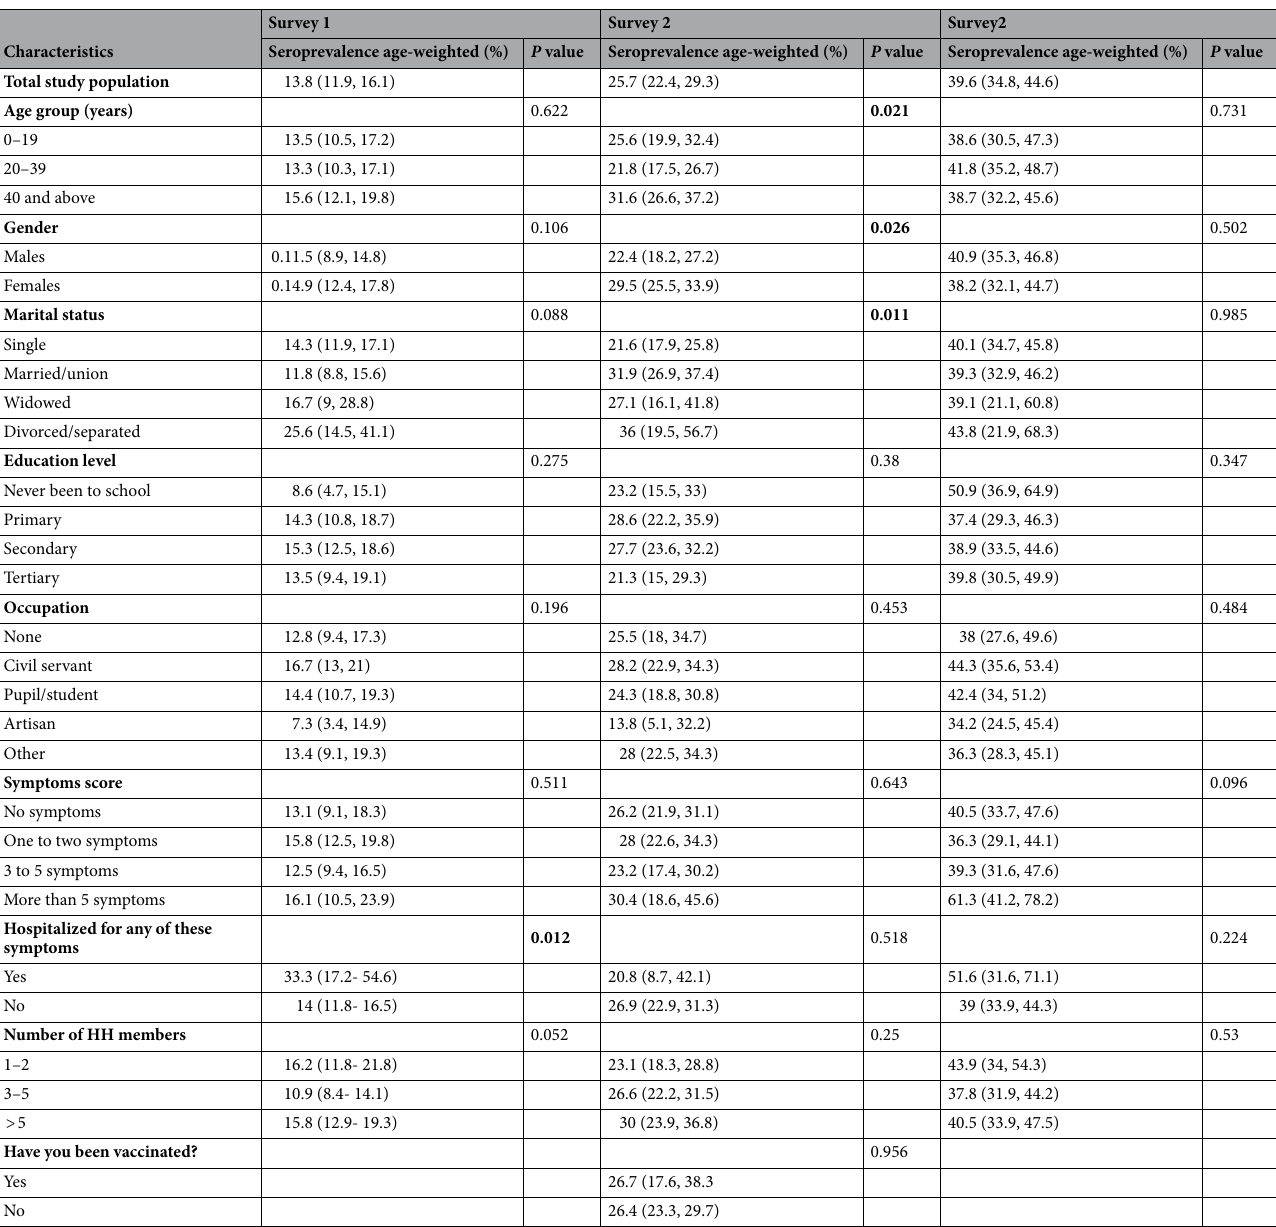
Table 2. Univariate analysis showing association of symptoms with sero-positivity. Significant values are in